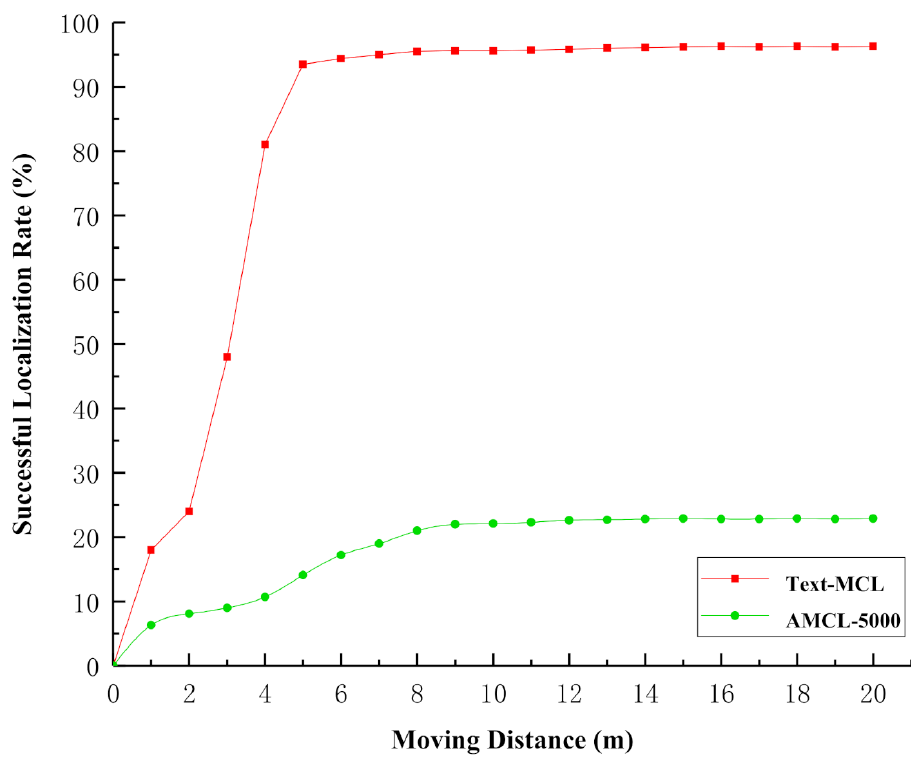
Figure 12. Relationship between successful localization rate and moving distance.